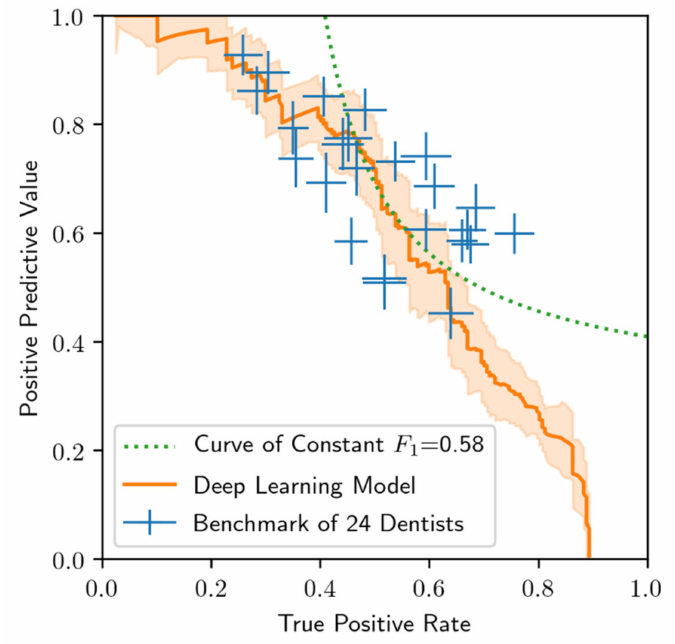
Figure 5. Comparison of 24 OMF surgeon and model performance on the test data set. Standard errors (whiskers), computed via a jackknife analysis. The curve of constant F 1 score equal to 0.58 shown is used to compare performance results in Figure 3.